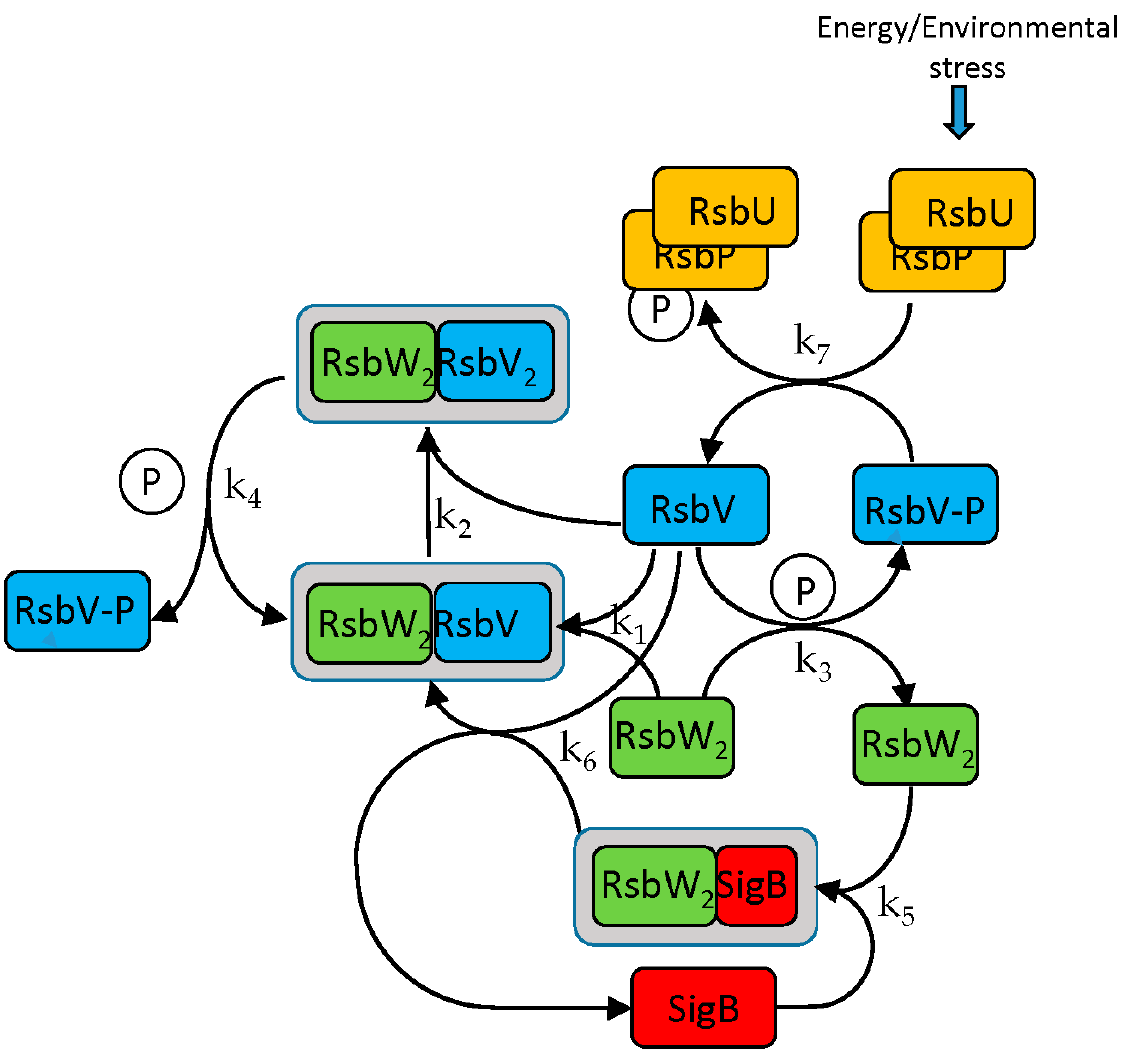
Figure 1. SigB regulatory network. Anti-anti-sigma factor RsbV is dephosphorylated by two phos- phatases, RsbP and RsbU. Dephosphorylated RsbV binds to the RsbW 2 anti-sigma factor dimer to release SigB bound in a complex with RsbW 2 . RsbW also has a protein kinase activity that phosphorylates and inactivates RsbV. P represents phosphate. Complete description in the form of chemical Equations (ch1)–(ch8) is given below. k 1 –k 7 are corresponding kinetic constants. Grey frame represent